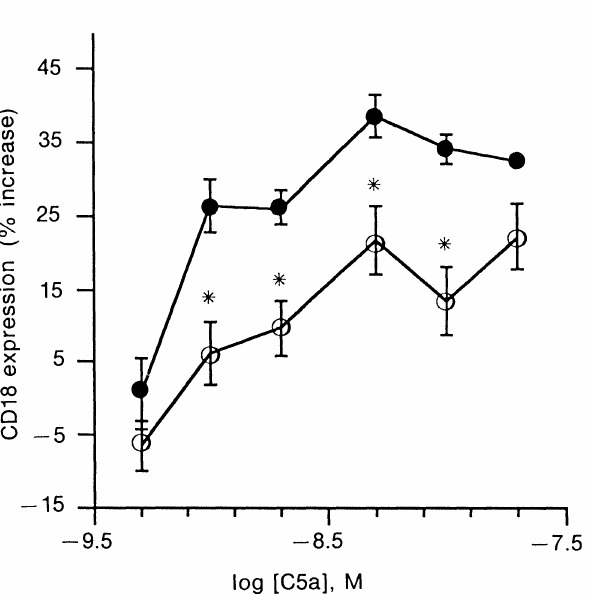
FIG. 2. NPC 15669 inhibition of C5a mediated increase in CD18 expression in vitro. Buffer (100#1 HHBSS-) with (O) or without (O) NPC 15669 (final concentration 100#M), was added to 100#1 of heparinized blood from a normal pig. After a 15 min incubation at room temperature, one-tenth volume H HBSS with or without C5a (final concentration 0.5-20 nM) was added. After 20min at 37C, samples were placed on ice and anti-porcine CD18 antibody or HHBSS was added to appropriate samples. All samples were then labelled with FITC-GAMIg. Red blood cells were lysed and leukocytes fixed prior to measurement of cellular fluorescence. Fluorescence values were converted to percentage increase over control and expressed as the mean _+ S.E.M. (n 3). *p <